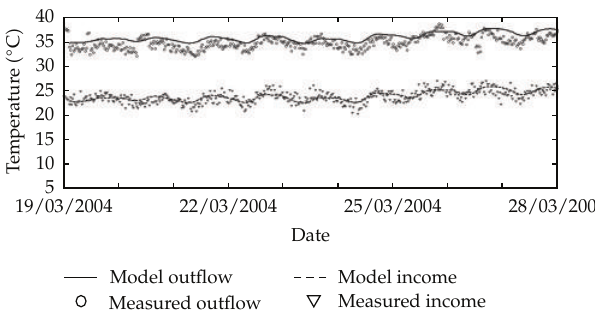
Figure 10: Comparison of the measured and modeled temperaturesin the income and outflow of the power plant with the 5th and 6th units in operation for the days between 19 and 28 March 2004.